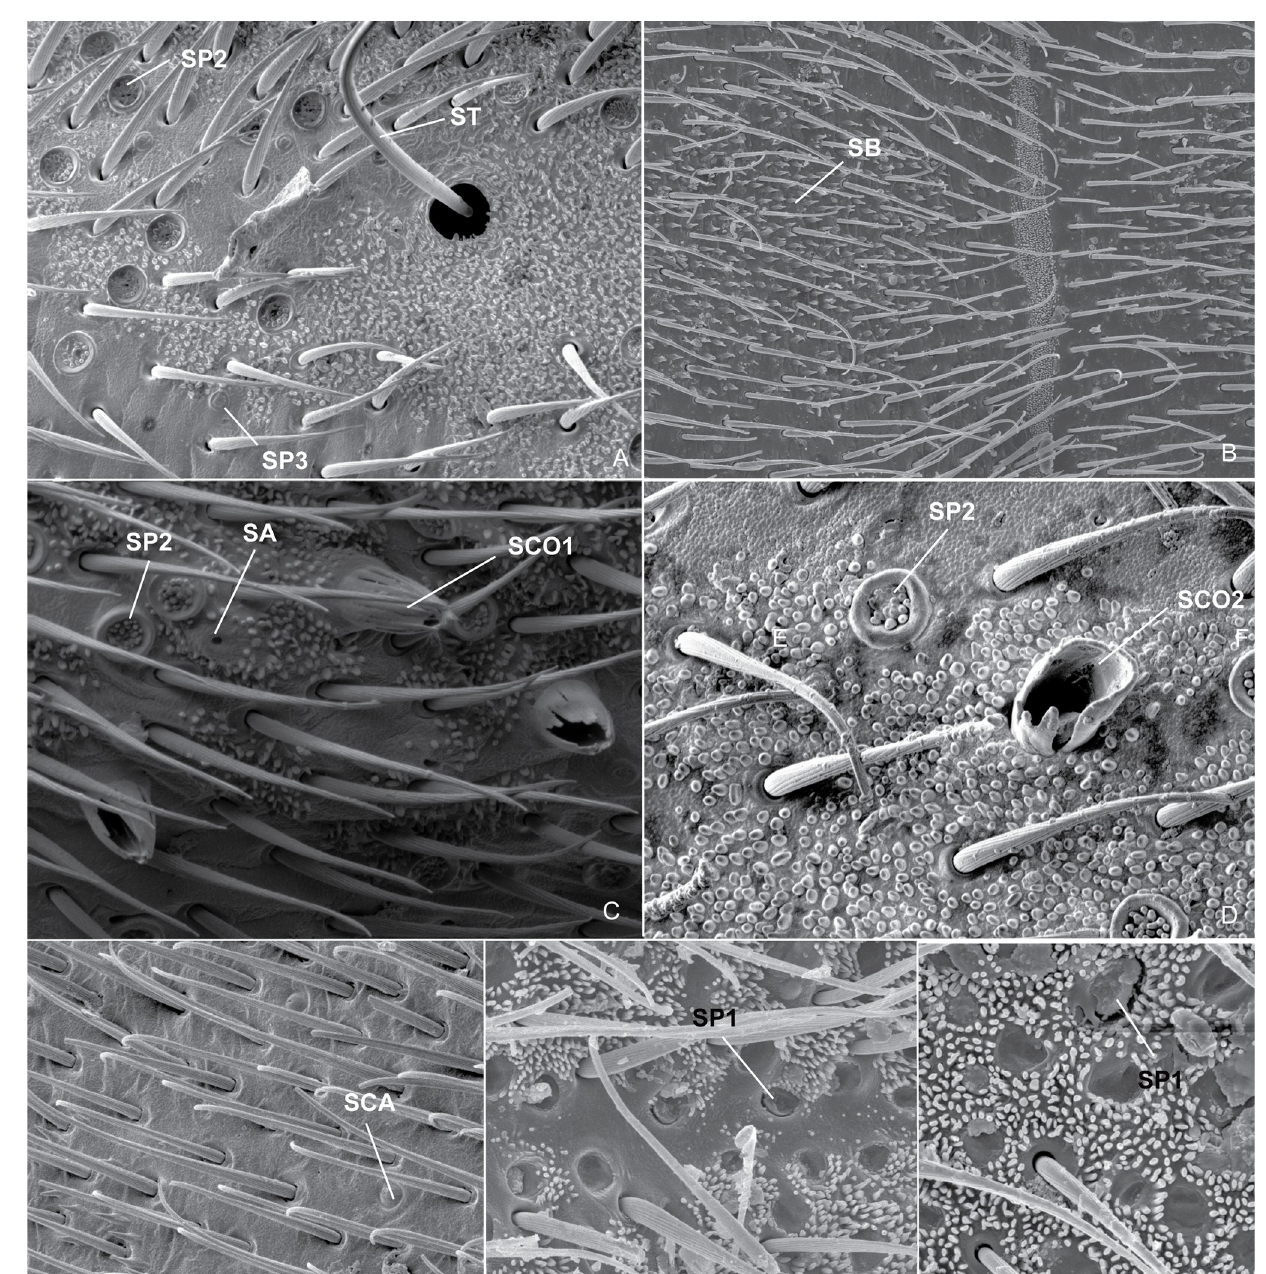
Fig 21. Scanning electron micrographs. (A) P . horvathi , head, dorsal view; (B) P . unidentatus , abdominal mesotergites II-III, dorsal view; (C) P . horvathi , propleuron, lateral view; (D) P . unidentatus , propleuron, lateral view; (E) P . shuar , mesotergite VII, dorsal view; (F) P . unidentatus , mesonotum, dorsal view; (G) P . unidentatus , head, dorsal view. SA : Sensilla ampullacea; SB : Sensilla basiconica; SCA : Sensilla campaniformia; SCO1 : Sensilla coeloconica 1; SCO2: Sensilla coeloconica 2; SP1 : Sensilla placodea 1; SP2 : Sensilla placodea 2; SP3 : Sensilla placodea 1; ST: Sensilla trichoidea. https://doi.org/10.1371/journal.pone.0280405.g021 stripes, posterior margin with golden setae; dorsal 3/4 of spiracle covered by golden setae. Mesopleuron with longitudinal stripe of golden setae, stripe sigmoid, slightly curved, posteri- orly discontinue; mesosternum with blackish mark anteriorly below proacetabula and a pair of blackish marks on posterior third; limit between meso- and metasterna darkened; middle and